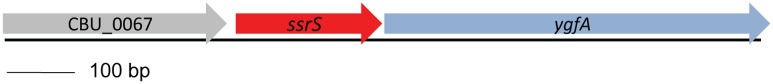
Linkage map showing the location of C. burnetii’s 6S RNA gene (ssrS).
ssrS is encoded in the 5′, untranslated region (UTR) of ygfA (encoding formyl tetrahydrofolate cyclo-ligase; CBU_0066). The gene immediately upstream (CBU_0067) encodes a hypothetical protein.